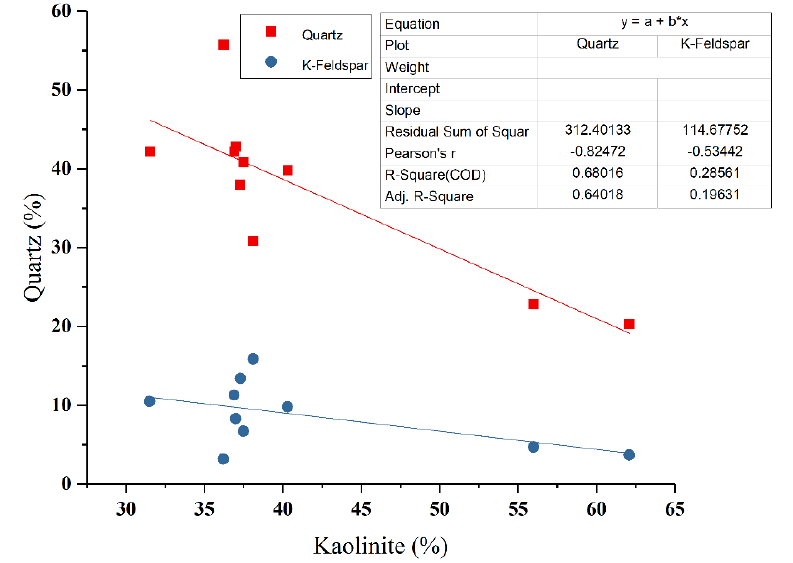
Figure 6. Correlation trend of kaolinite, Potassium feldspar, and quartz in samples from Anyuan County. The relationship between average particle size (Dav) and kaolinite, quartz, and potassium feldspar indicates that the mineral particle size had only a minor effect on the clay mineral content. Quartz and potassium feldspar are mostly distributed on both sides of kaolinite. Quartz is further away from the X -axis, while potassium feldspar is closer to the X -axis. This distribution, therefore, further confirms that weathering of potassium feldspar has a significant impact on the formation of kaolinite.